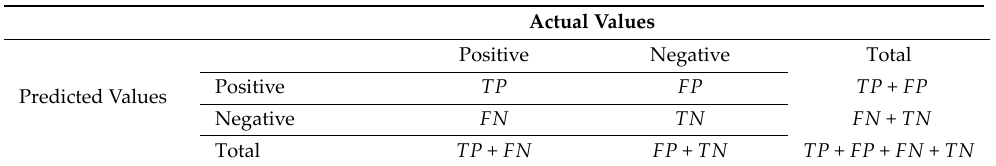
Table 3. The confusion matrix for evaluating a binary classification system, where TP = True Positive, FP = False Positive, FN = False Negative and TN = False Negative. Actual Values